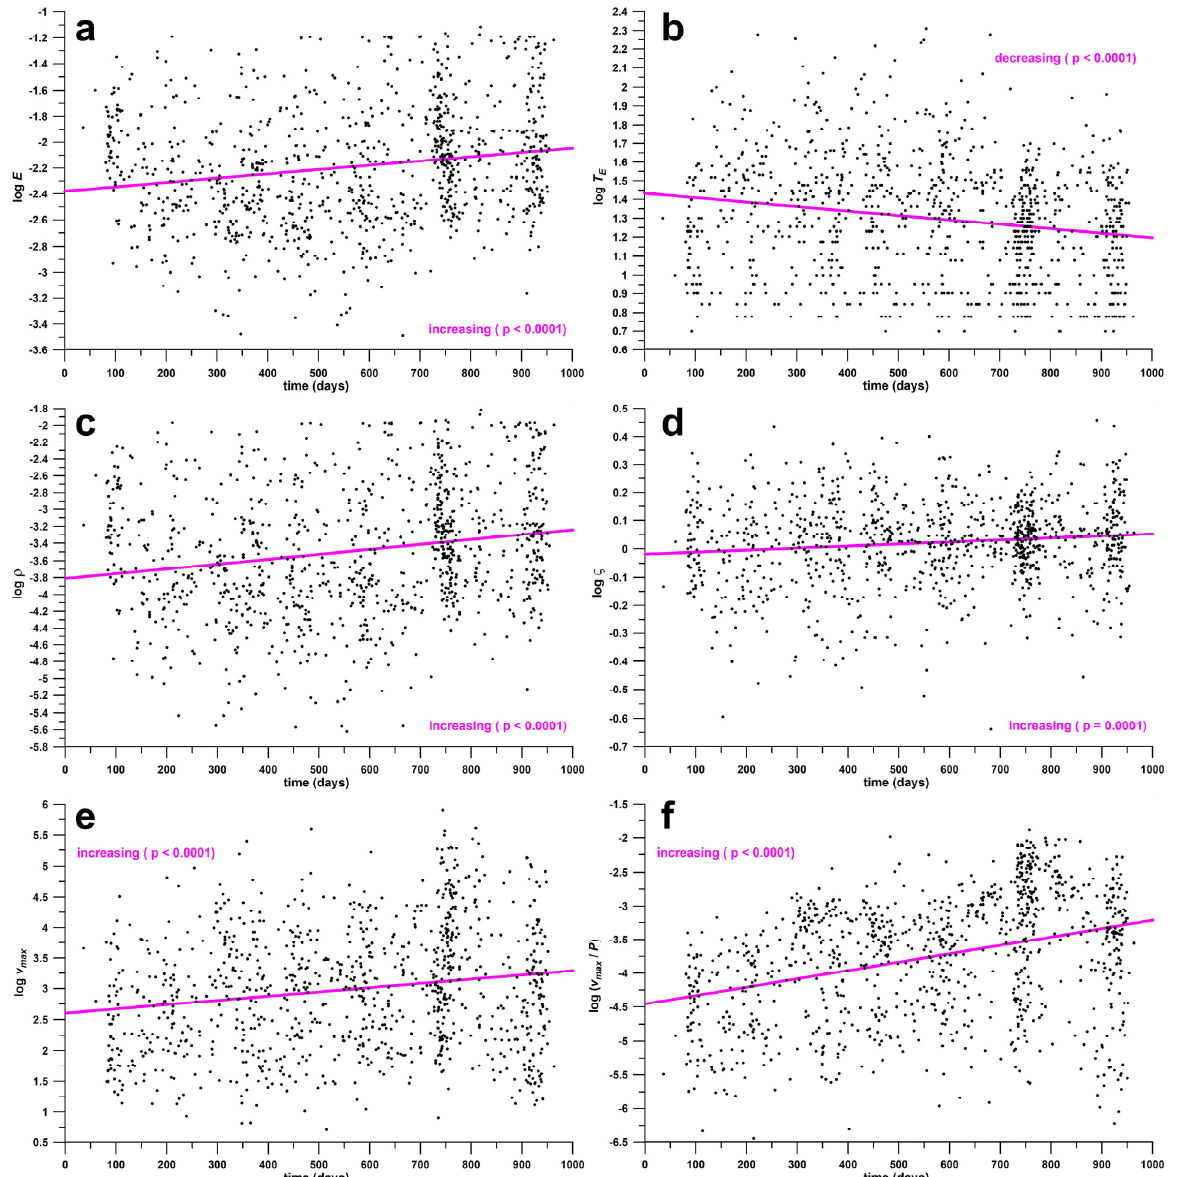
Figure 6. Regressions; ( a ) effectiveness E data of 1000 waves against time; ( b ) duration of the effective phase T E against time; ( c ) ρ against time; ( d ) log ς against time; ( e ) peak velocity v max against time; ( f ) peak velocity per population ( v max /P) against time; note that the two bands with greater wave density, at approximately 750 and 925 days are Omicron waves.